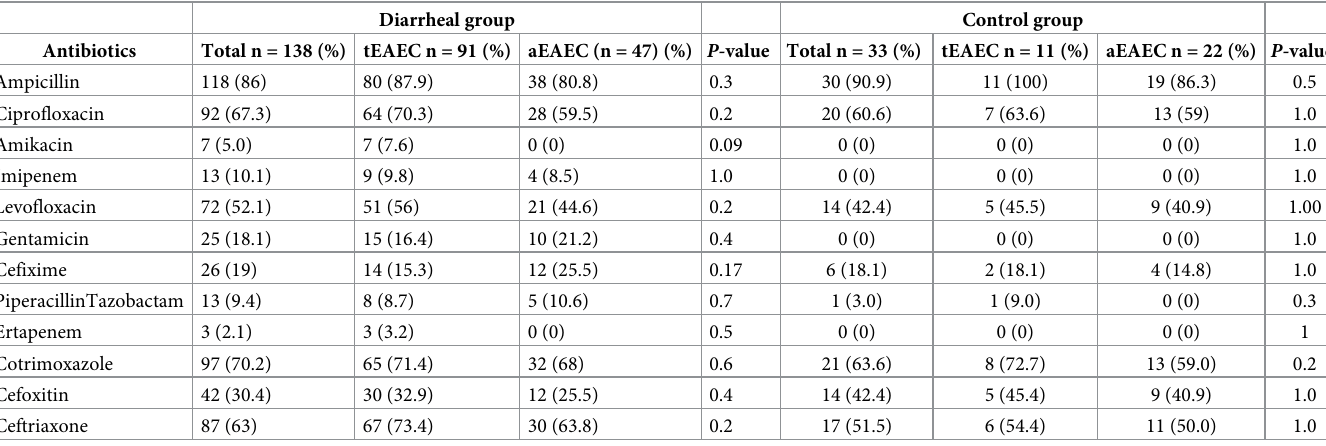
Table 10. Antibiotic resistance in tEAEC and aEAEC strains isolated from the diarrheal and control group. Diarrheal